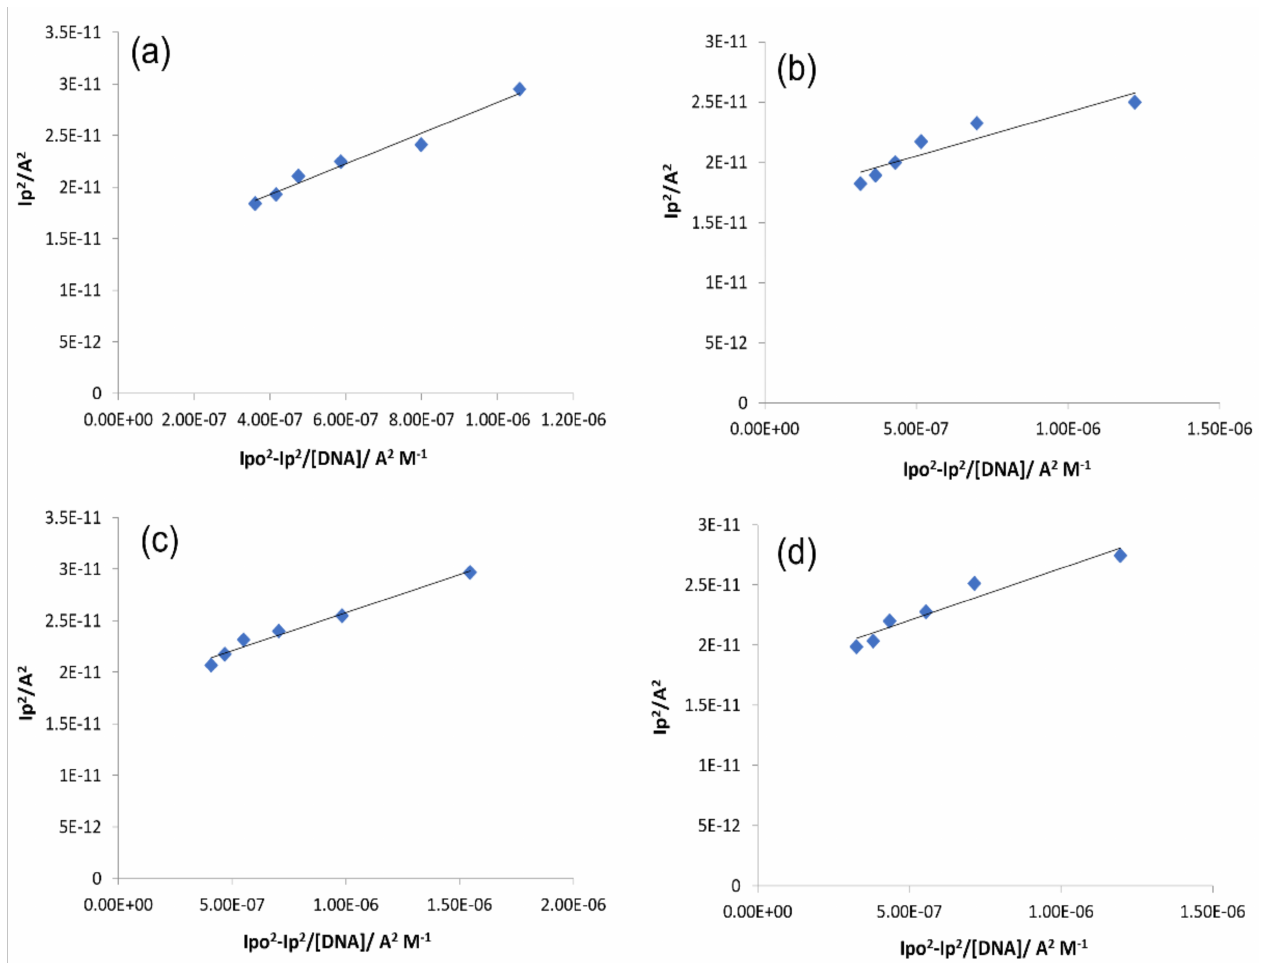
Figure 11. Graphs for the calculations of the binding constant using Equation (5) for compound–DNA complex. ( a ) IST-01–DNA, ( b ) IST-02–DNA, ( c ) IST-03–DNA, ( d )